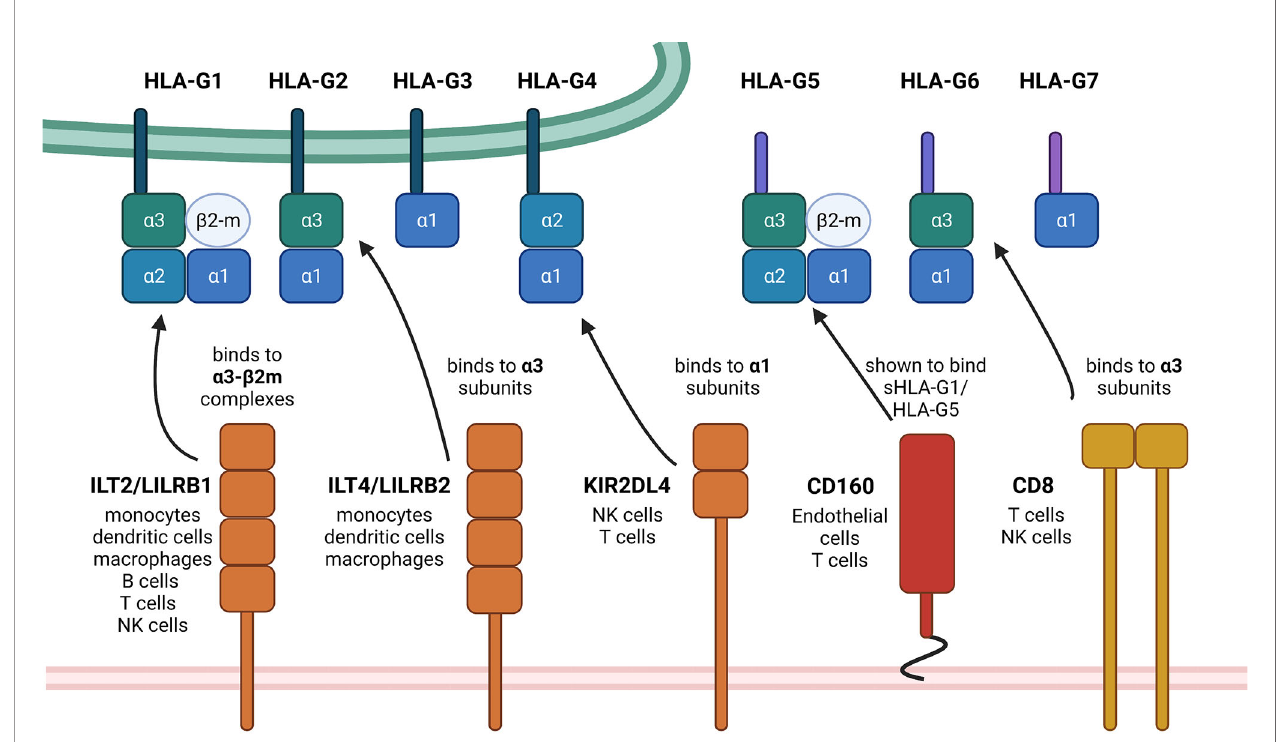
FIGURE 1 | Summary of HLA-G isoforms with their binding positions for the so far known receptors. This schematic summary of the structural differences of HLA-G isoforms shows the so far known HLA-G receptors and also designates the exact binding position. The black arrows show exemplarily, but not exclusively possible interactions, depending on mentioned binding positions on the HLA-G ligands. There exist fi rst evidence of a possible interaction between NKG2A with HLA-G, which still needs to be investigated in more detail. Therefore, NKG2A is not yet mentioned within this scheme. Created with